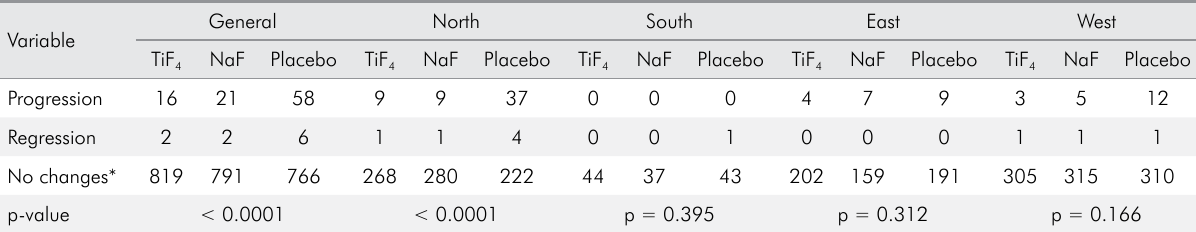
Table 1. Numbers of tooth surfaces (all smooth surfaces of permanent teeth) with progression, regression or no progression/ regression after 18 months of treatment with TiF